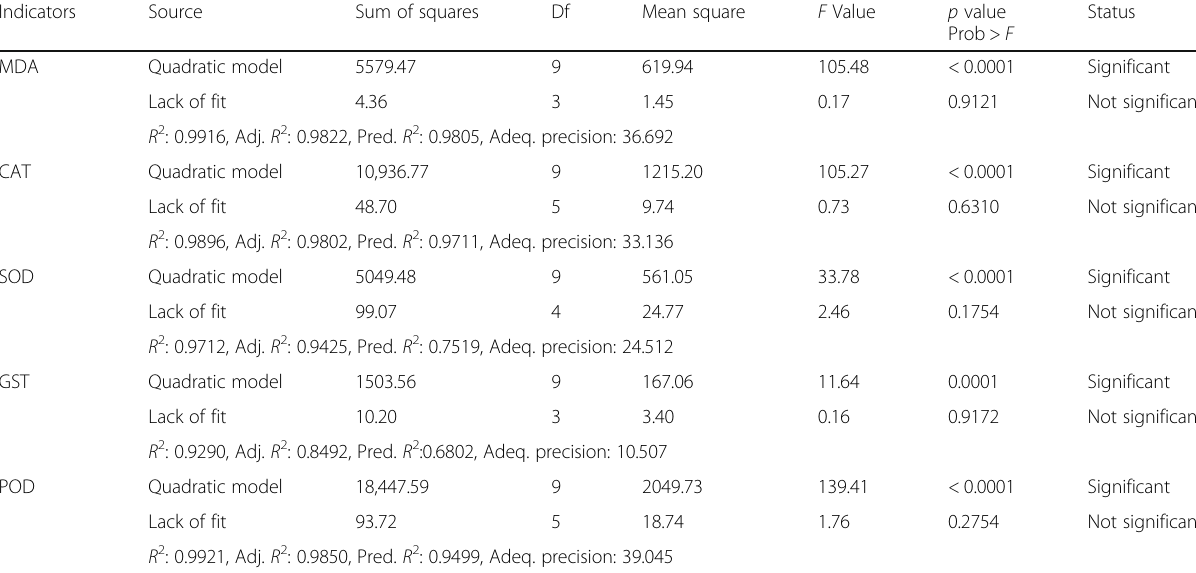
Table 3 Analysis of variance (ANOVA) for serum oxidative-antioxidative indicators in relation to input variables